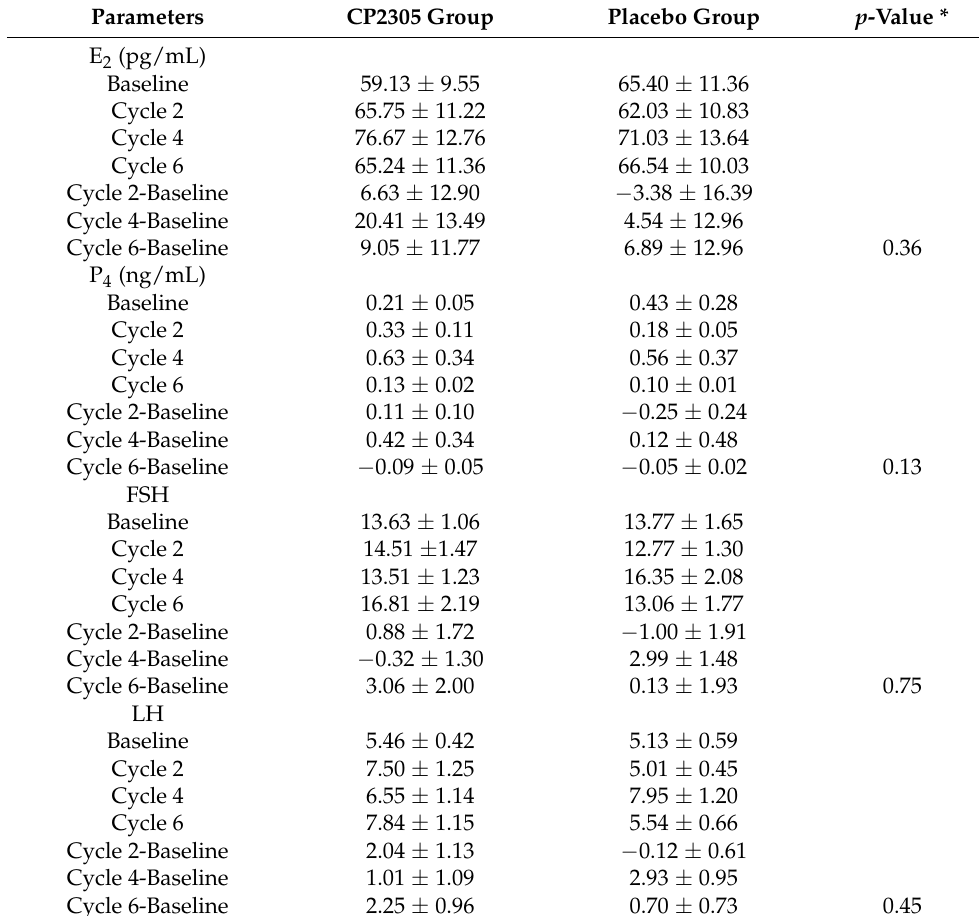
Table 3. Concentration of reproductive hormones during the follicular phase.